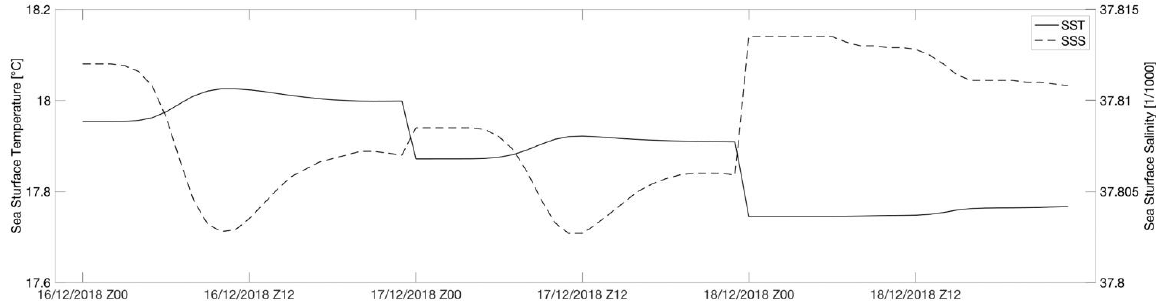
Figure 7. Calculation of sea surface temperature and salinity in the study area between 16 and 18 December 2018. The simulation was performed using the RMS3 numerical model.